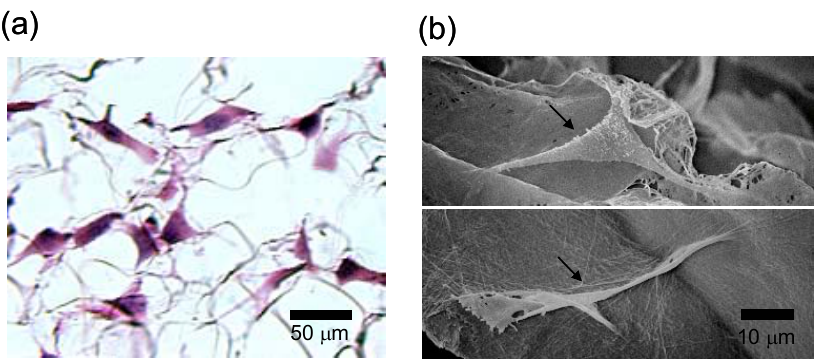
Fig. 4 Histology of osteoblasts (MC3T3-E1 cells) in a collagen sponge scaffold. (a) The image of a HE stained section, representing the distribution of osteoblasts in the scaffold. (b) SEM image of osteoblasts on the surface of the scaffold (freeze-fracturing method). The arrow points osteoblasts.